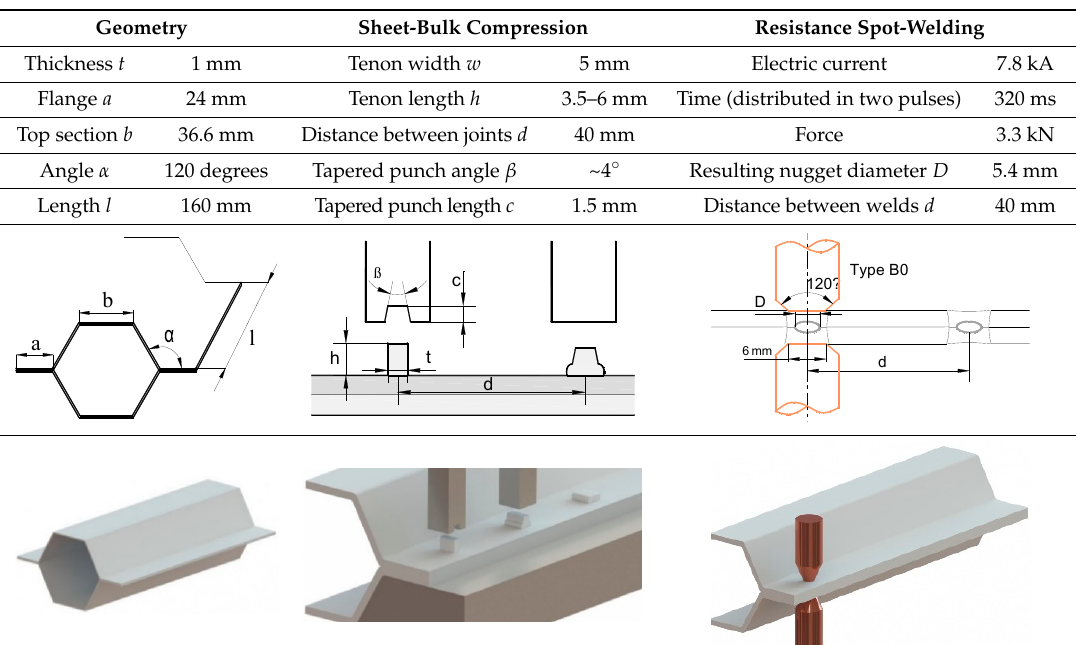
Table 2. Geometry and parameters of the thin-wall crash boxes assembled by sheet-bulk compression with “mortise-and-tenon” joints and by conventional resistance spot-welding.